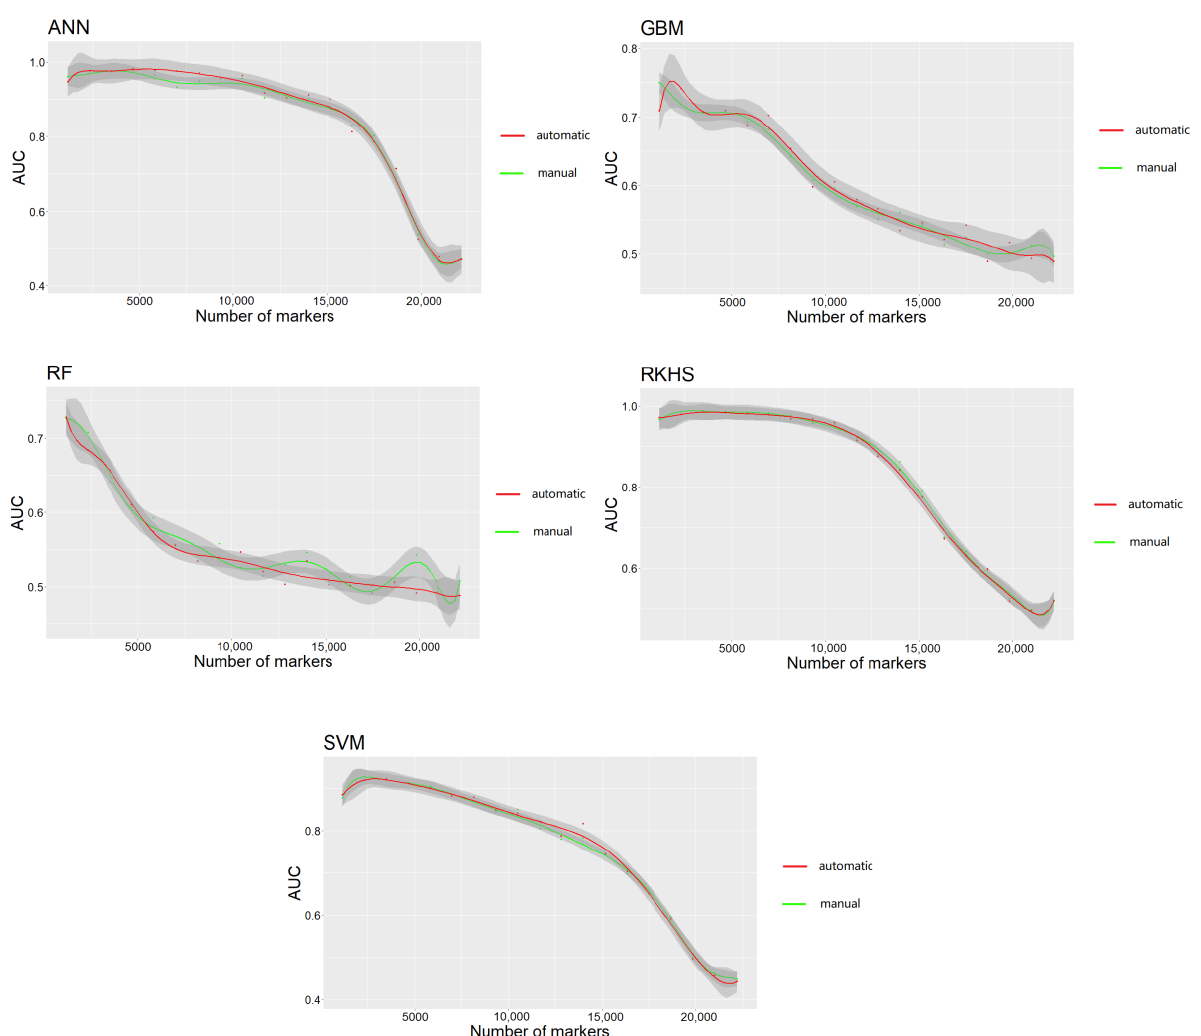
Figure 5. A comparison of AUC (area under the curve) scores of manual hyperparameter adjustment and automatic hyperparameter adjustment of five machine-learning algorithms. The C. gigas survival trait dataset was used for this analysis.